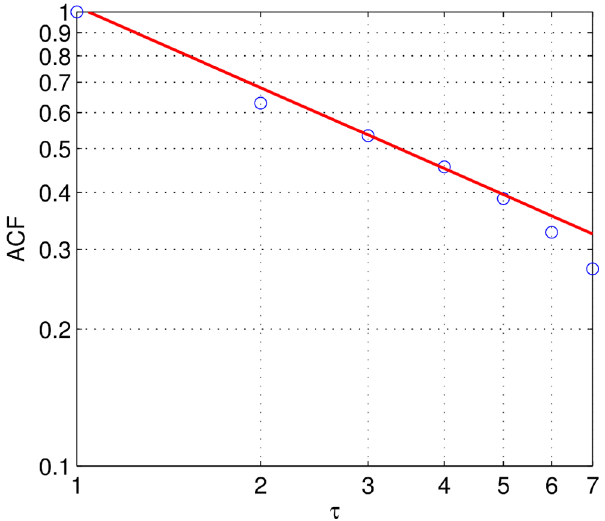
Figure 4. Gowalla: Decomposition of the growth into indepen- dent short-term correlated population growth processes. ACF for the three data sets according to the superposition scheme explained in the text. The power law exponents from fitting C ( t ) * t { d sur obtained from the decomposition via surrogate data (sur). Best fits from MLE: d sur ~ 0 : 59 ( R 2 ~ 0 : 986